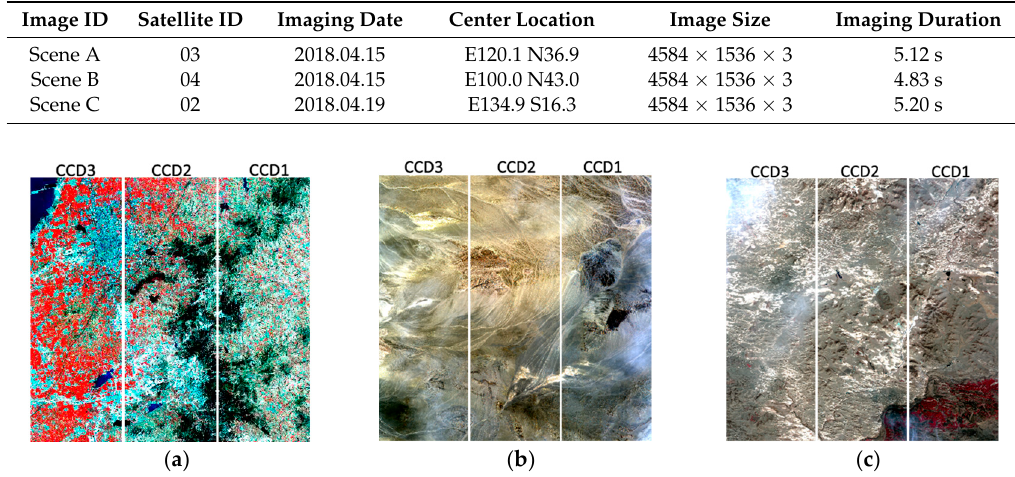
Figure 3. Thumbnails of ( a ) Scene A, ( b ) Scene B, and ( c ) Scene C (band combination: infrared, green, and blue).